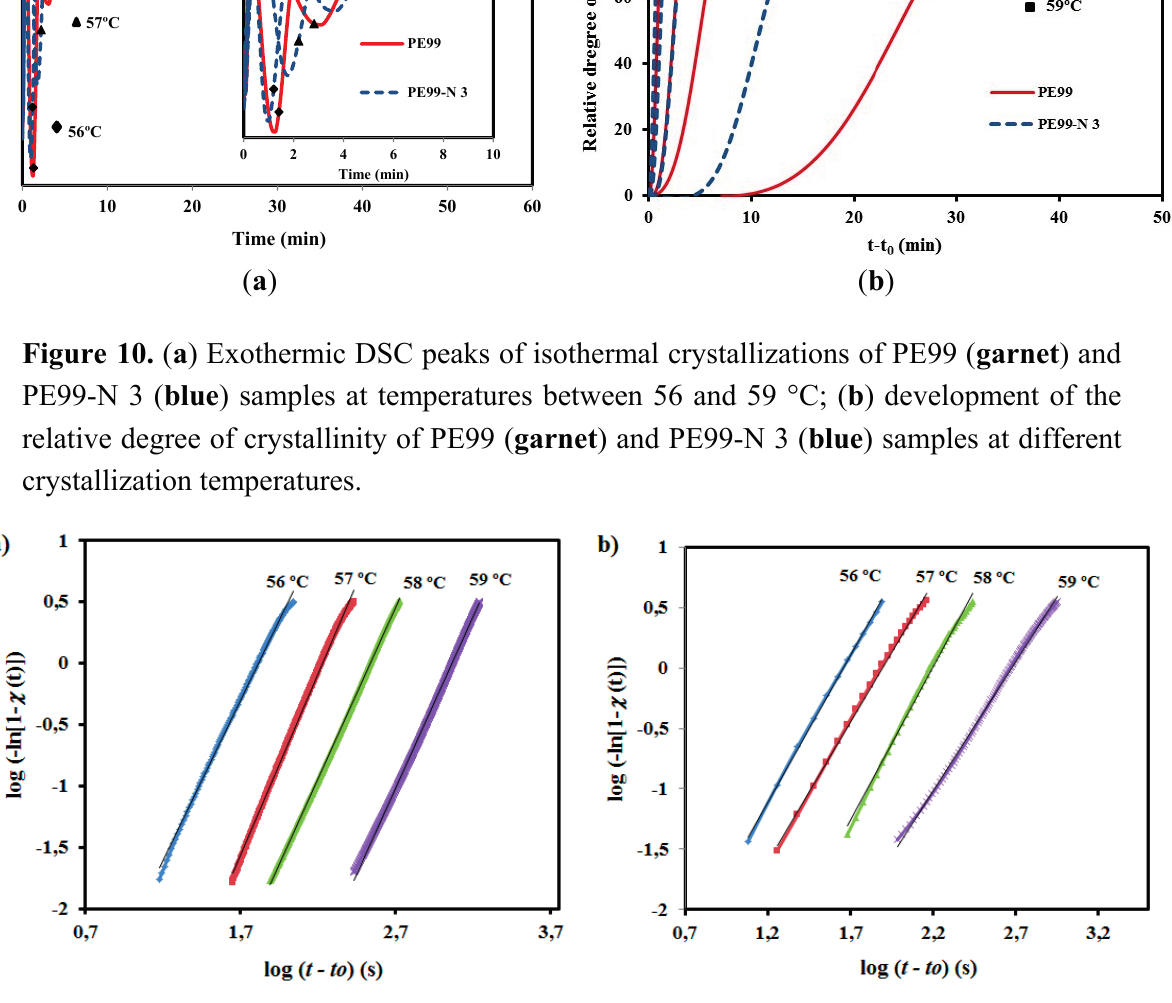
Figure 11. Avrami plots of isothermal crystallization of PE99 ( a ) and PE99-N 3 ( b) at the indicated temperatures. Table 3. Main crystallization kinetic parameters determined by DSC for the neat polyester and its nanocomposite with 3 wt. % of functionalized silica nanospheres.